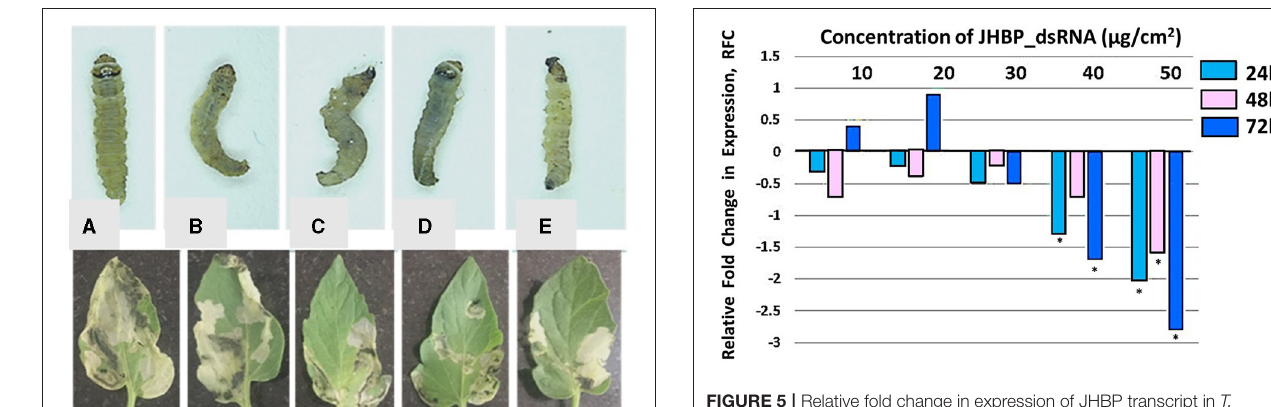
FIGURE 5 | Relative fold change in expression of JHBP transcript in T. absoluta larvae, post feeding access on JHBP-dsRNA-treated leaf. RT-qPCR was used to access the expression levels at 24, 48, and 72h post feeding access periods on dsRNA treatments at different concentrations (10, 20, 30, 40, and 50 µ g/cm 2 leaf). Relative expression levels were determined with respect to expression in the control at each time-point. Analysis was carried out by one-way ANOVA (*P < 0.0001); multiple comparison (n = 9), biological replicates with three technical